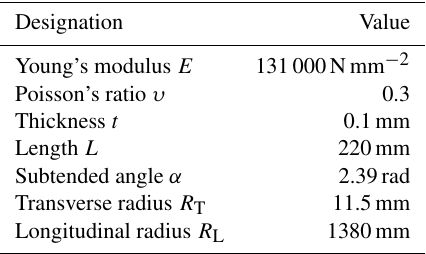
Table 1. Material properties and geometrical dimensions of the curved strip for FEA